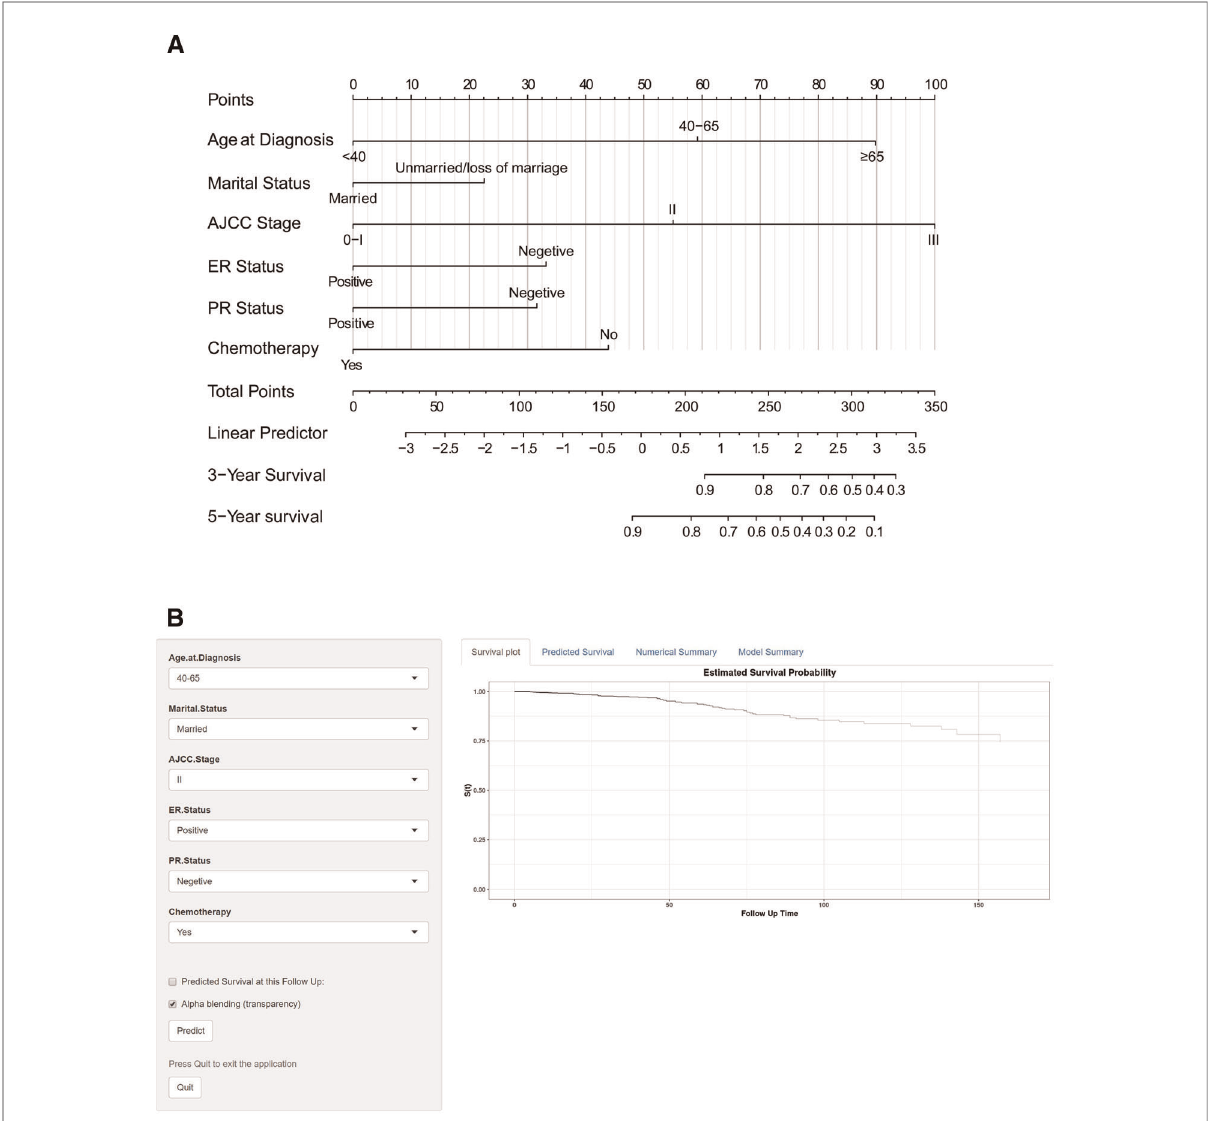
FIGURE 4 The ( A ) prognostic nomogram and ( B ) the online dynamic nomogram for 3- and 5-year overall survival (OS). When using the nomogram model, the upward vertical line drawn for each variable was adopted to obtain its risk score. Total points were calculated by adding each risk score and drawing a downward vertical line, which illustrated the probability of 3- and 5-year OS. AJCC, American Joint Committee on Cancer; ER, estrogen receptor; PR, progesterone